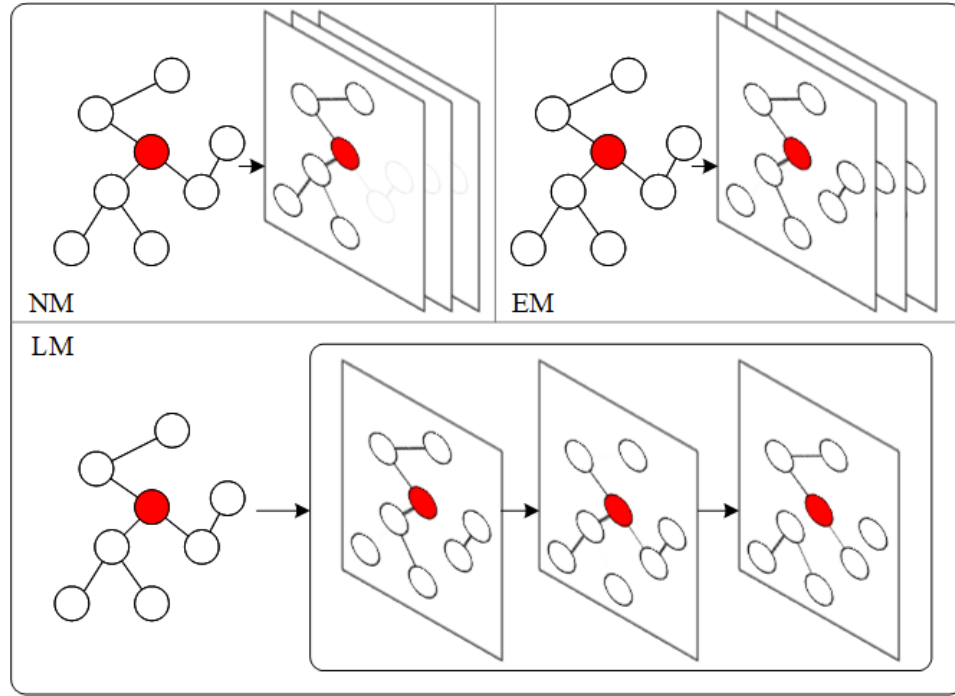
Figure 3. Graph augmentation method. Top left is node mask, top right is edge mask, and bottom is layer